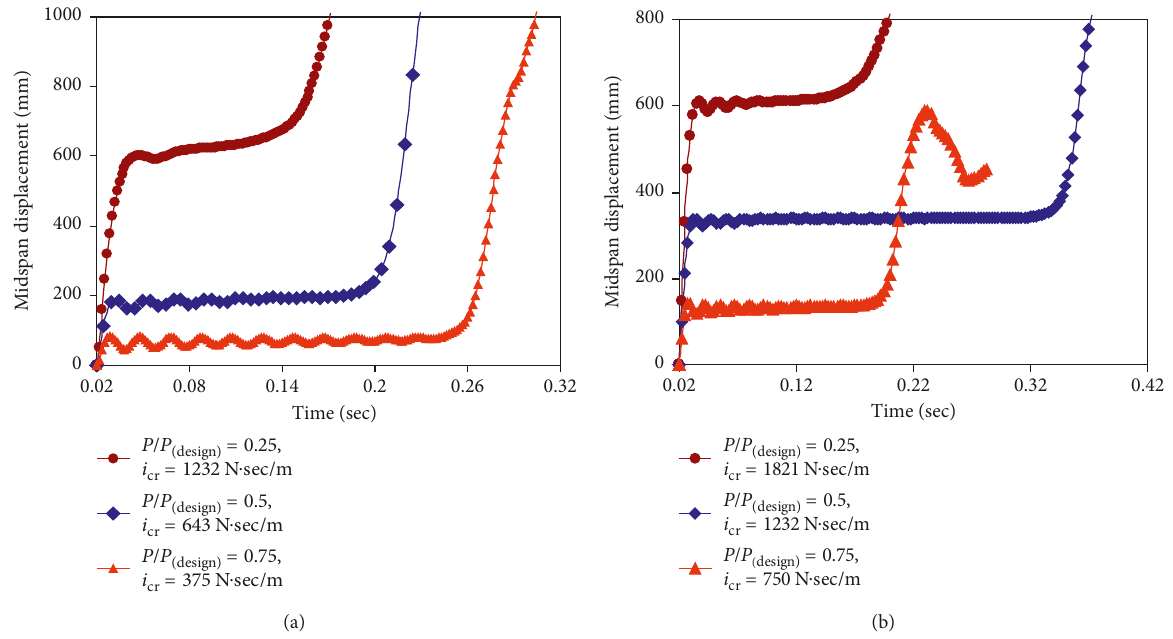
Figure 11: Midspan displacement time histories of steel column W150 (b) Propped